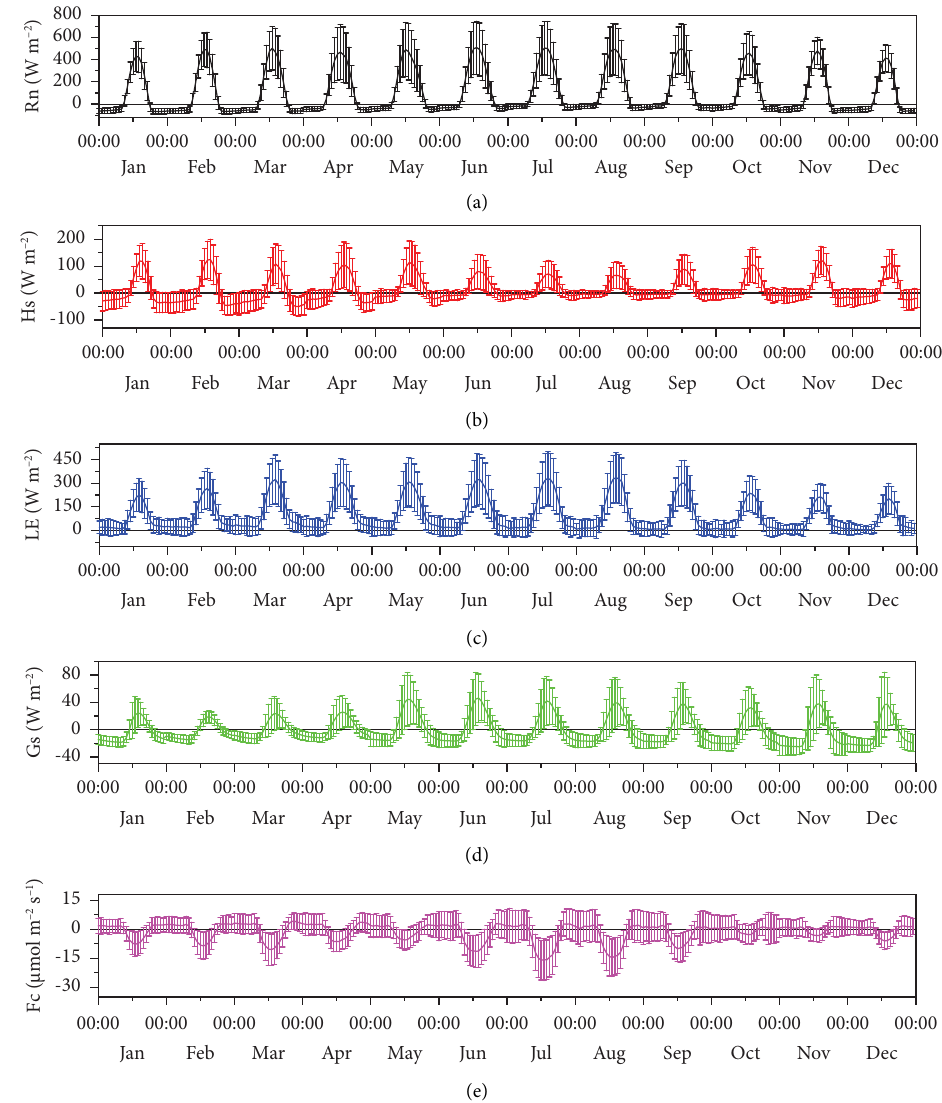
Figure 7: Monthly average diurnal variations in net radiation fux (Rn) (a), sensible heat fux (Hs) (b), latent heat fux (LE) (c), and soil heat fux (Gs) (d), and monthly average diurnal variation in CO 2 fux (Fc) (e) from 2007 to 2018. Te error bars indicate plus or minus one standard